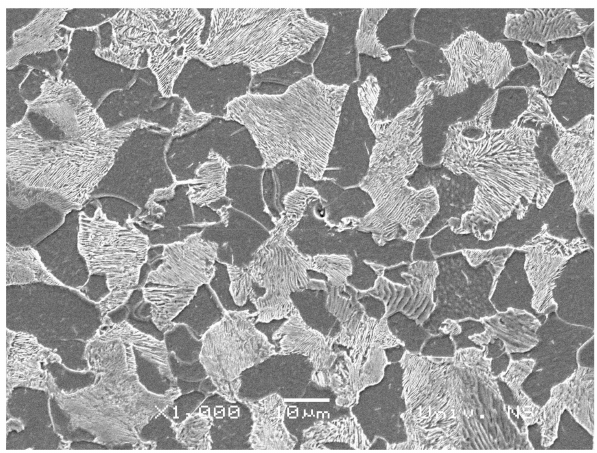
Figure 2. Illustration of the initial microstructure of samples (the average equivalent diameters of pearlite colonies and ferrite grains are 20 µ m and 13.5 µ m respectively).